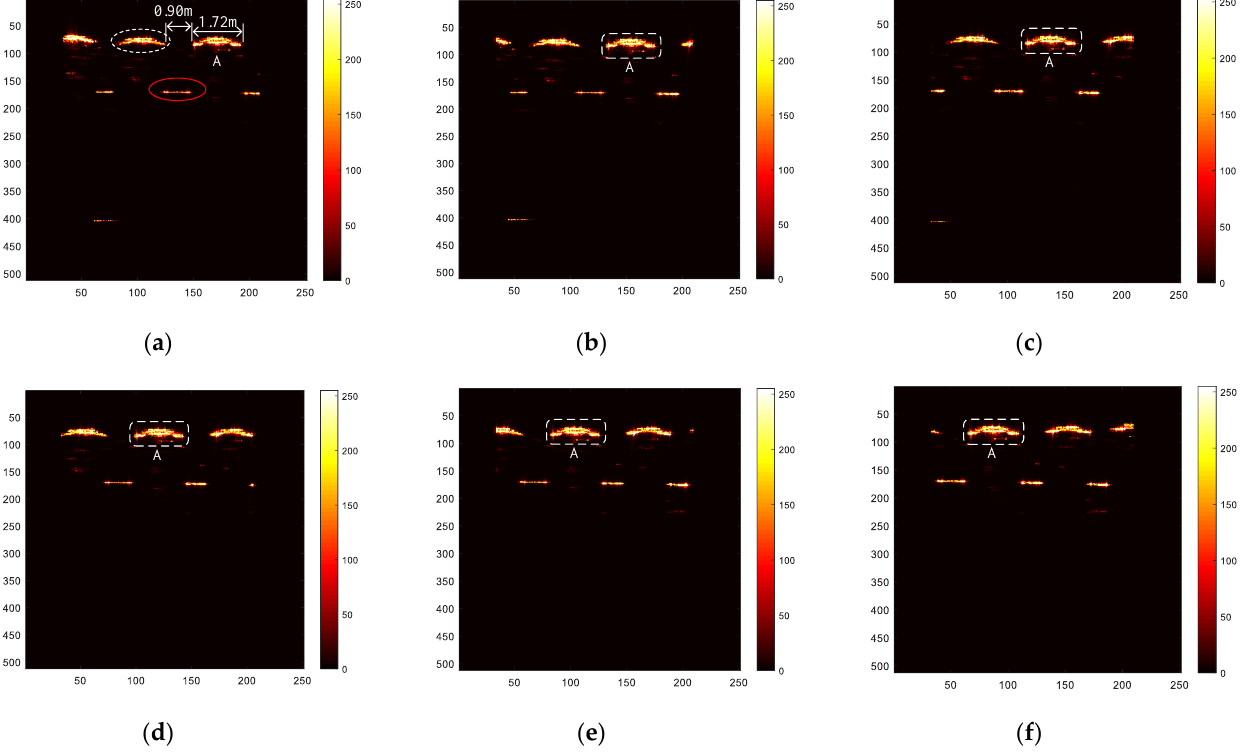
Figure 15. ViSAR imaging result of actual data. ( a ) First frame image; ( b ) Second frame image; ( c ) Third frame image; ( d ) Fourth frame image; ( e ) Fifth frame image; ( f ) Sixth frame